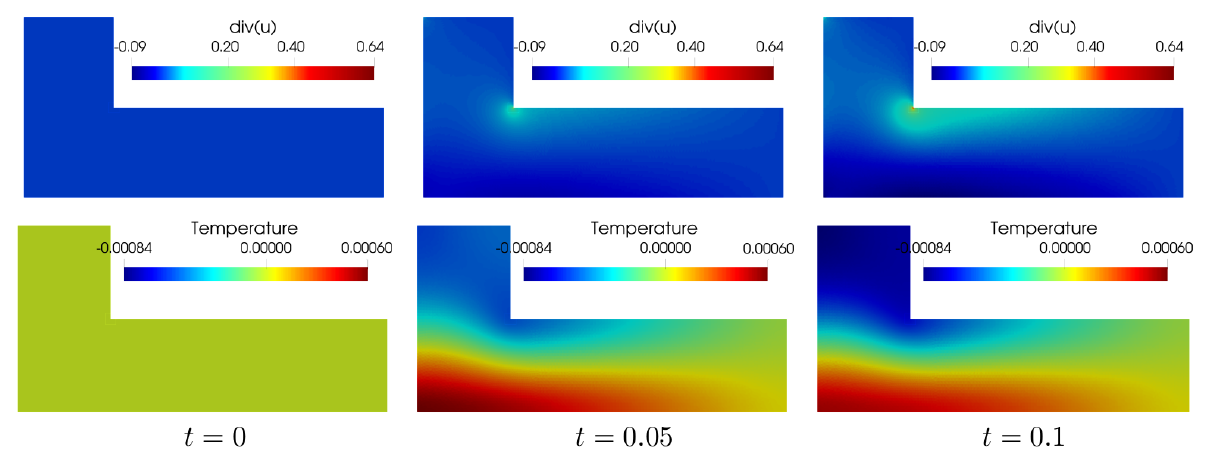
Figure 3. Snapshots of div u ( upper ) and the temperature ( lower ) of the L-shape cantilever for t = 0, 0.05, 0.1 using δ = 0.1. Near the re-entrant corner, the domain is expanded (div u > 0), and the temperature decreases. On the other hand, near the bottom boundary, the domain is compressed (div u < 0), and the temperature increases.